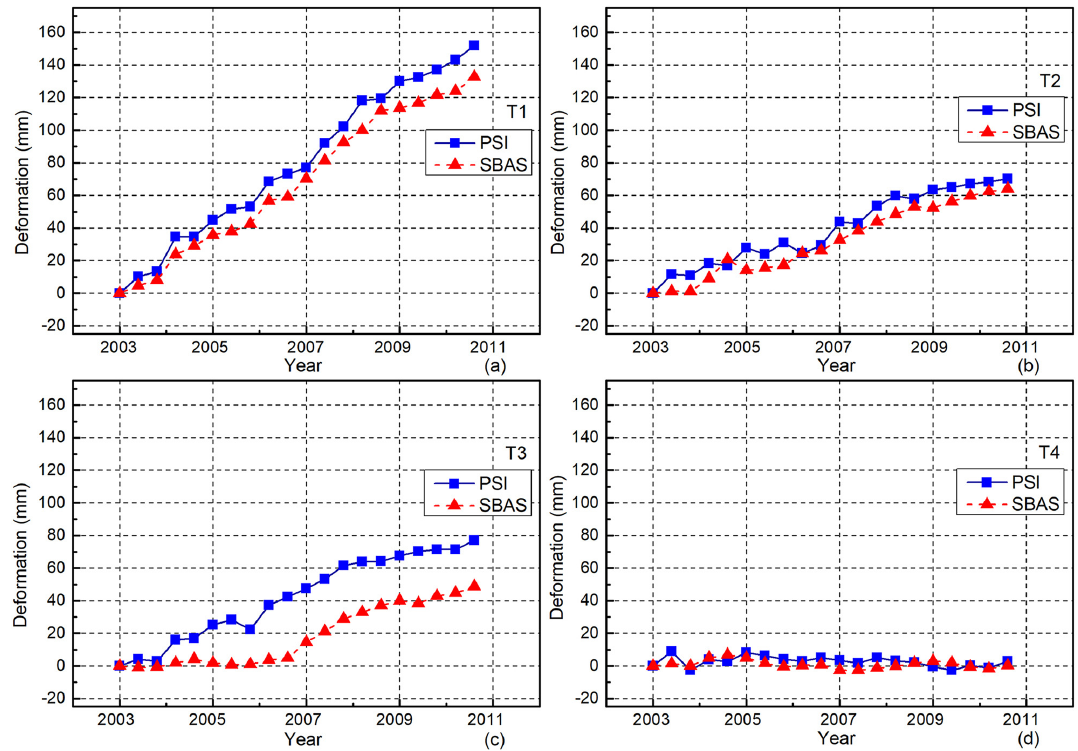
Figure 8. ( a – d ) Comparison of time series deformation obtained by the PS-InSAR and SBAS-InSAR methods at the selected locations T1 to T4 (Figure 7).